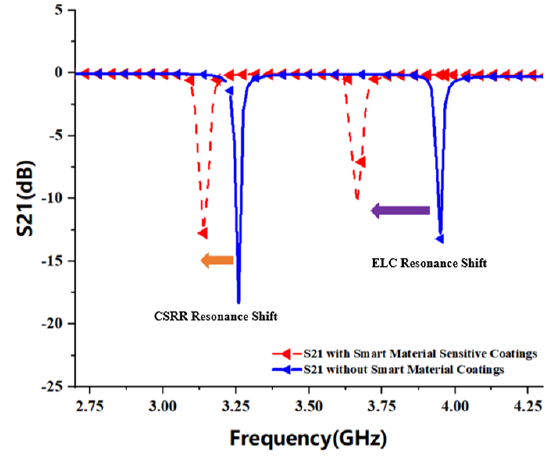
Figure 5. Simulate the resonance shift effect of covering polymer films.